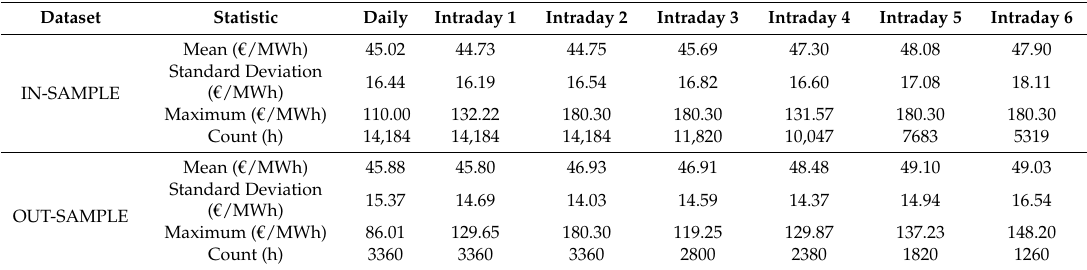
Table 2. Descriptive statistics of price data.